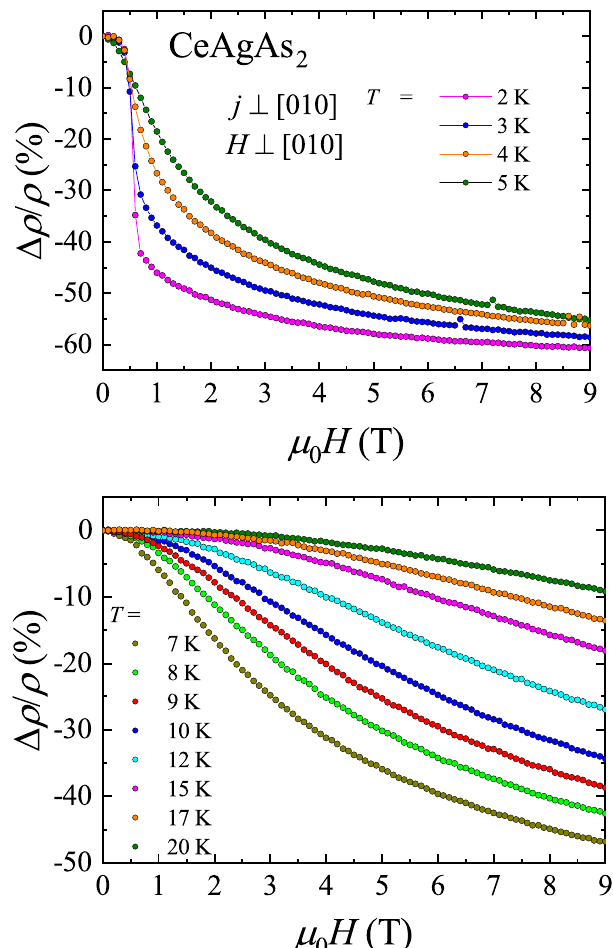
Figure 9. Transverse magnetoresistance isotherms of single crystalline CeAgAs 2 measured with j ⊥ [ 010 ] and H ⊥ [ 010 ] in the AFM state ( upper panel ) and the paramagnetic state ( lower panel ).